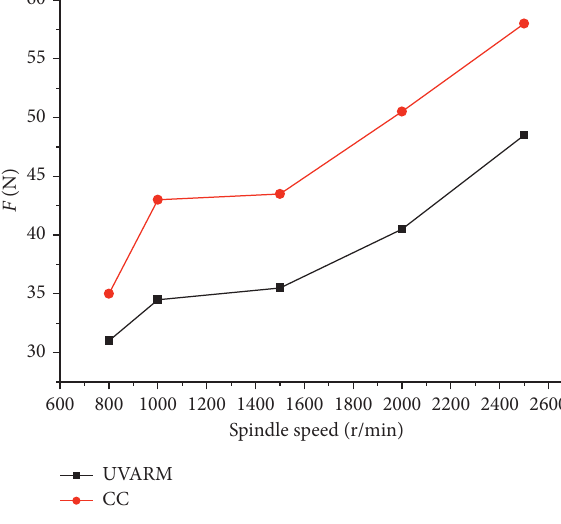
Figure 12: F changes with the spindle